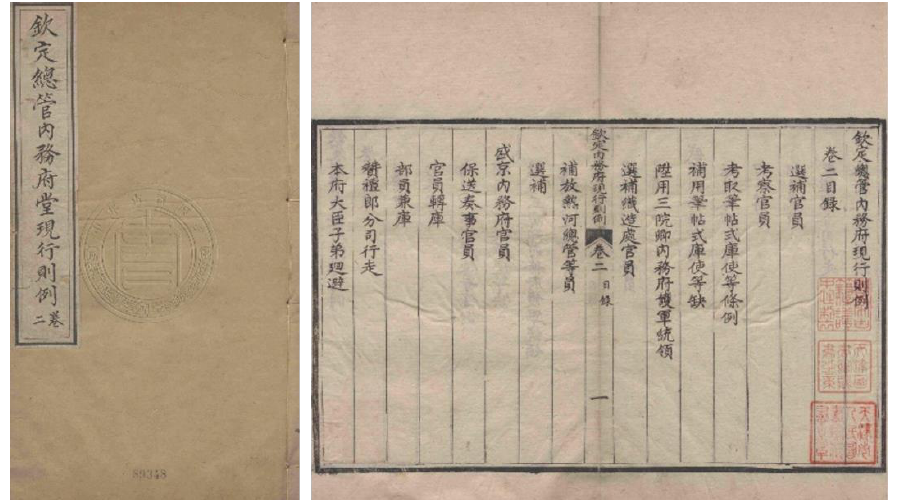
Figure 7. Scanned picture of Imperially Commissioned Precedents of the Imperial Household